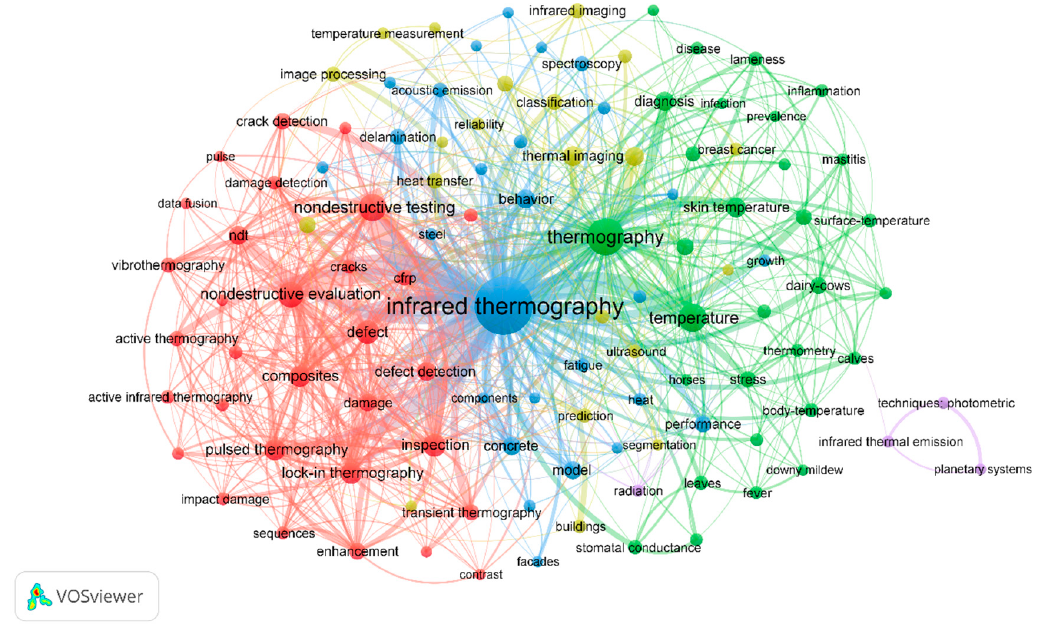
Figure 7. Keyword cocitation knowledge map of infrared detection technology studies.